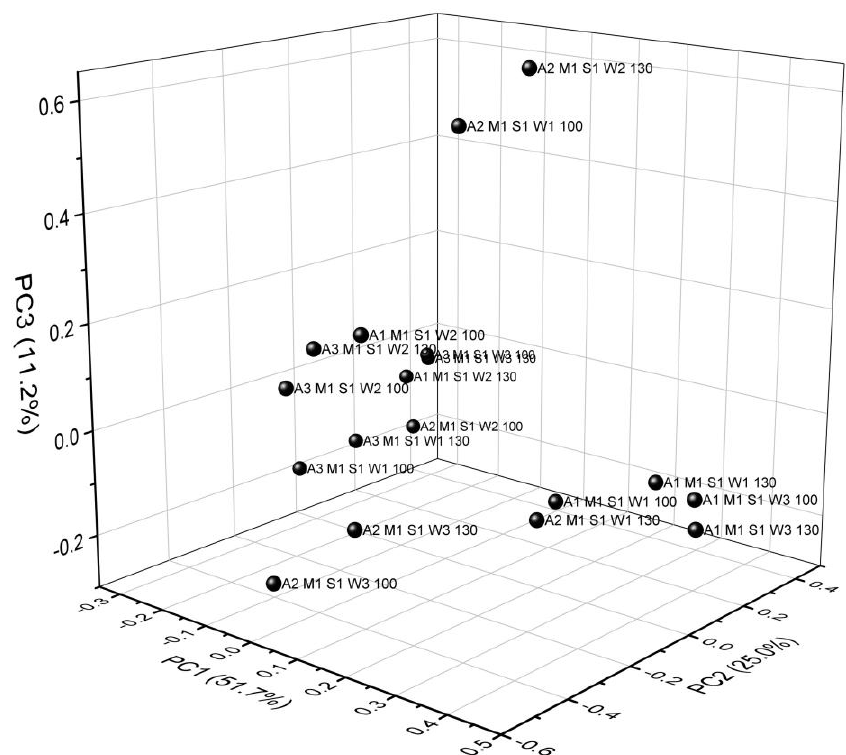
Figure 8. The scattered scores plot (PC1 × PC2 × PC3) based on FTIR spectra of M1 with various PVA addition.